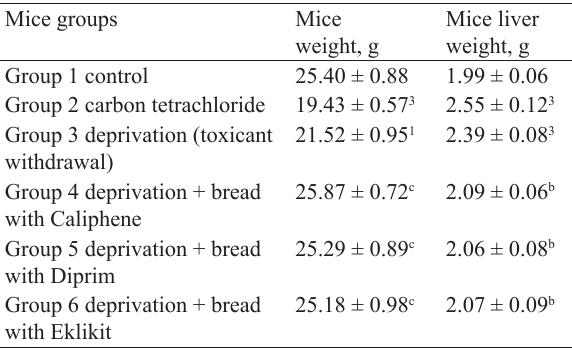
Table 2 Weight changes in carbon tetrachloride intoxicated mice and their correction with extract-containing breads (M ± m)